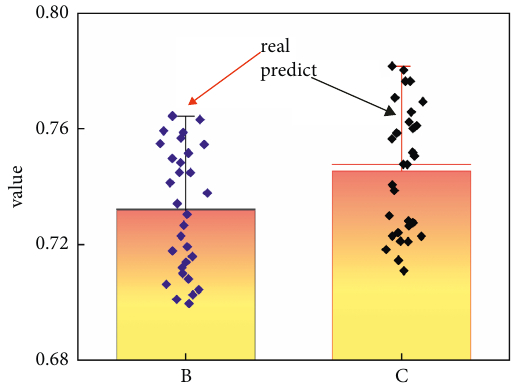
Figure 8: Predictive distribution box plot for classical